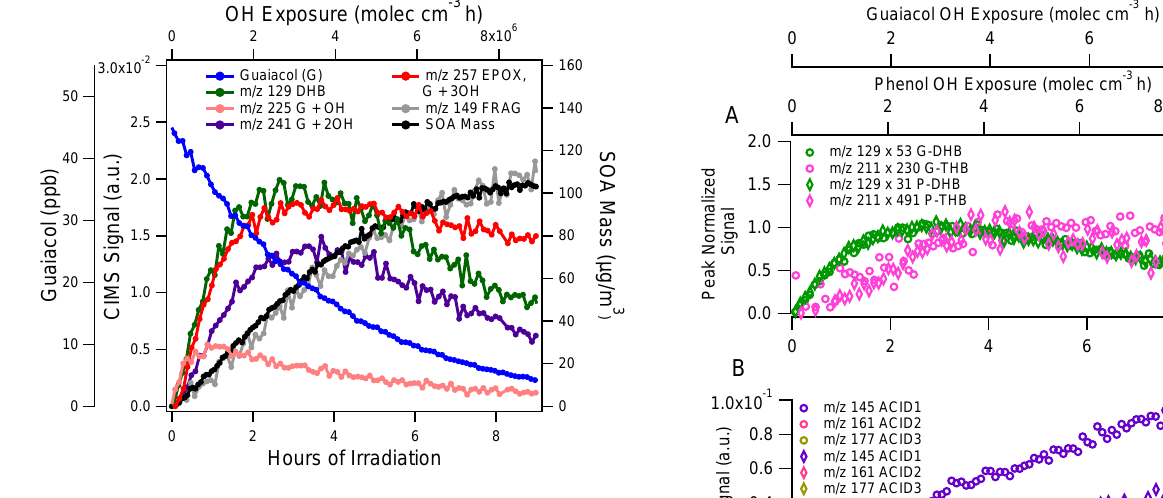
Fig. 5. Selected traces in guaiacol low-NO x gas-phase and particle- phase development.